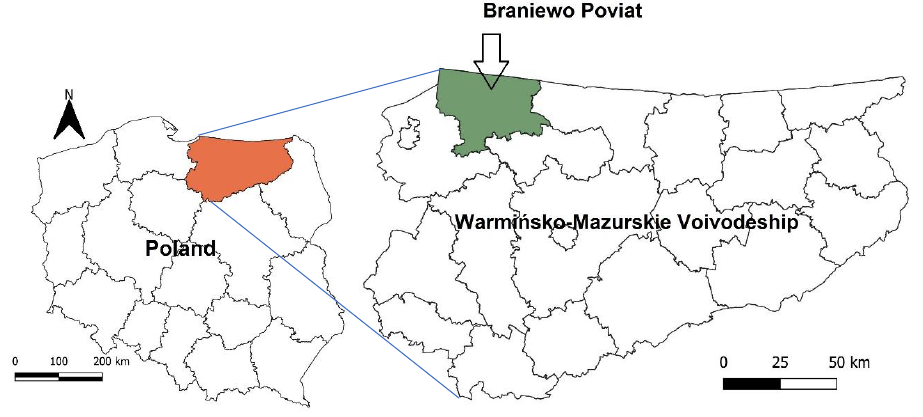
Figure 1. Location of the study area.